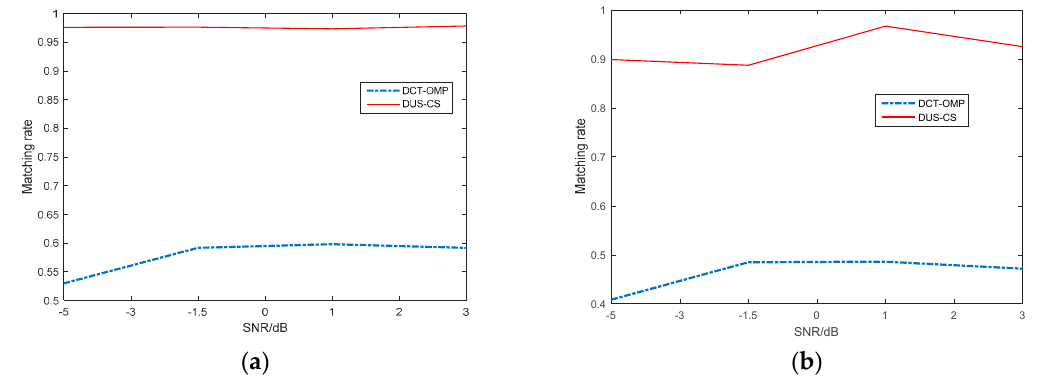
Figure 6. Variation of the matching rate with the SNR. ( a ) the compression ratio is 100%; ( b ) the compression ratio is 50%.